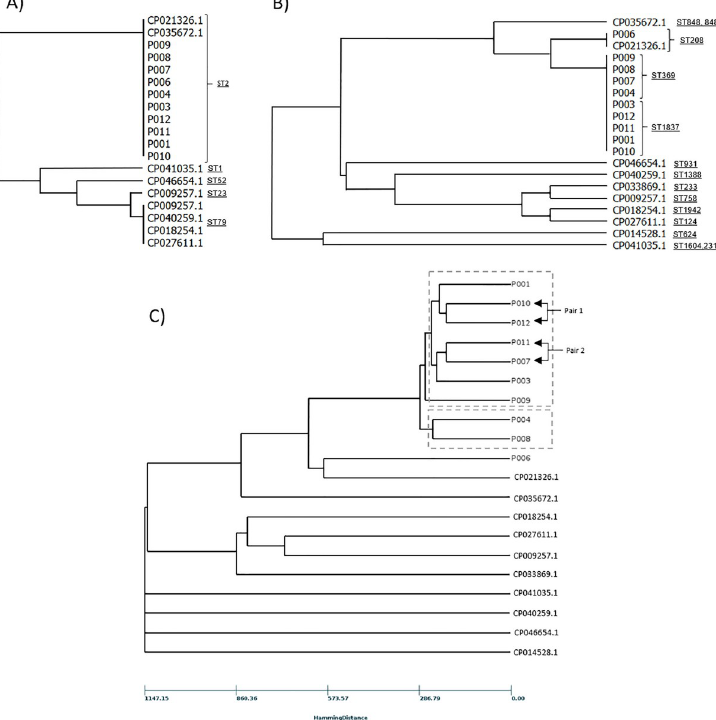
Fig 1. Genetic analysis of Acinetobacter baumannii strains. WGS were used to extract all loci required for Pasteur, Oxford schemes and cgMLST approach. The corresponding dendrograms were generated based on genetic distances among isolates and reference sequences. A) Pasteur scheme classified all isolates belonging to one distinctive sequence type (ST2). B) Oxford scheme grouped all outbreak sequences into two different sequence types (ST369 and ST1837). The unrelated sample derived from patient P006 was classified as ST208 along with reference strain CP021326.1. All other unrelated reference strains were classified as different ST. C) The cgMLST analysis showed a main branch with two distinctive clusters. Samples P004 and P008 formed a pair included in the small cluster while two pair of sequences (P010:P012 and P011:P007) were included in the major cluster along with samples P001, P003 and P009. Unrelates train P006 remained genetically distant from all other clinical